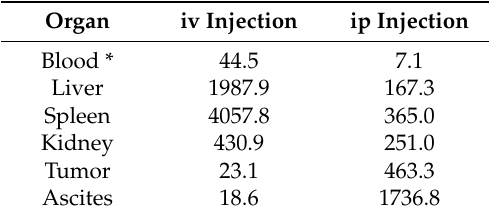
Table 5. A comparison of organ area under the curve (AUC) between iv and ip injection.